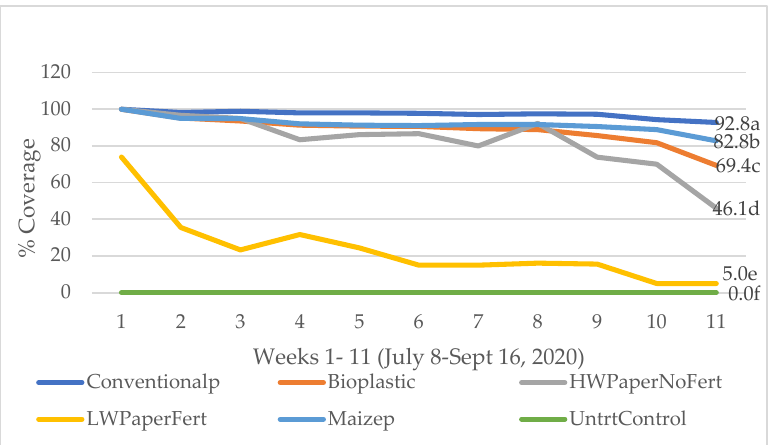
Figure 1. Mulch coverage throughout the study at the Baton Rouge, LA location. Mulch treatments with different letters are statistically significant at p < 0.05 using SAS Proc GLM with Duncan. Untrt Control = un-mulched raised beds; Maize p = biodegradable maize plastic mulch; Bioplastic = biodegradable bioplastic mulch; Conventional p = black polyethylene plastic mulch; HW Paper No Fert = heavy weight paper mulch without impregnated fertilizer; LW Paper Fert = light weight paper mulch with impregnated 3–3-3 fertilizer within the mulch.